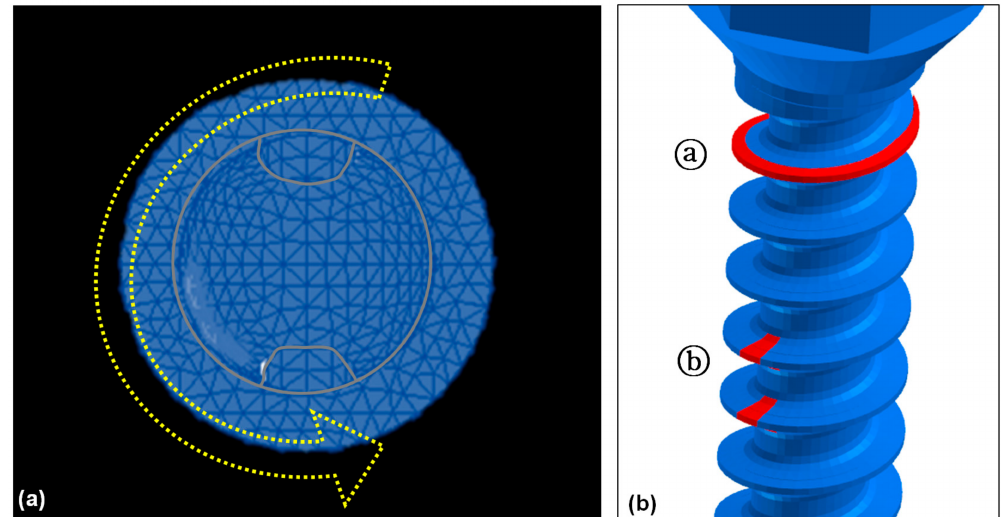
Figure 3. Force loading conditions to measure the rotational resistance of the orthodontic miniscrew: ( a ) Top view of the orthodontic miniscrew with a hole on the head. Yellow arrow indicates the counterclockwise rotating direction to unwind the orthodontic miniscrew; ( b ) Detailed view of two modifications in the threads of the orthodontic miniscrew. Red-colored part of the threads were cut additionally for the increase of the resistance. The uppermost part of the threads was narrowed ( ⓐ ), and the vertical notch was added at the middle of the threads at the uppermost part of the threads ( ⓑ ).